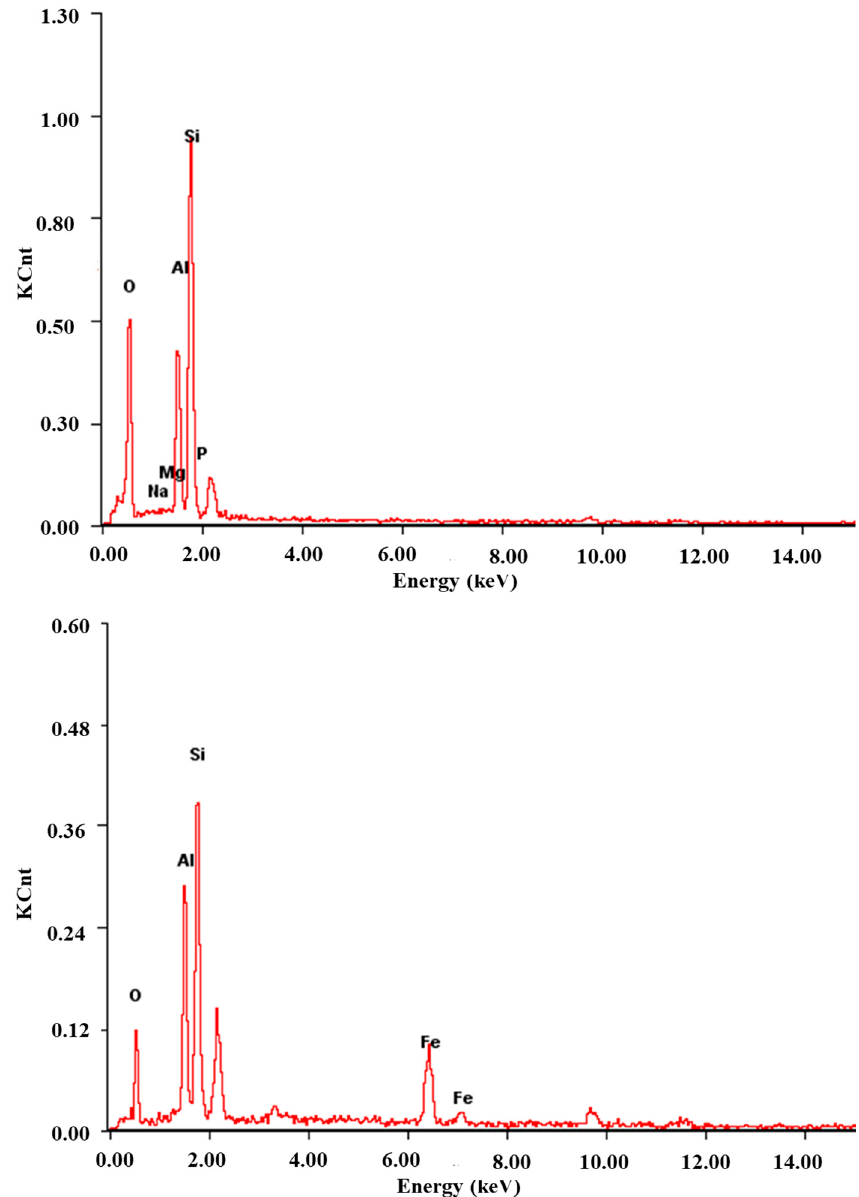
Figure 10. Composition of the elements in the sandstone sample, as found by SEM tests.